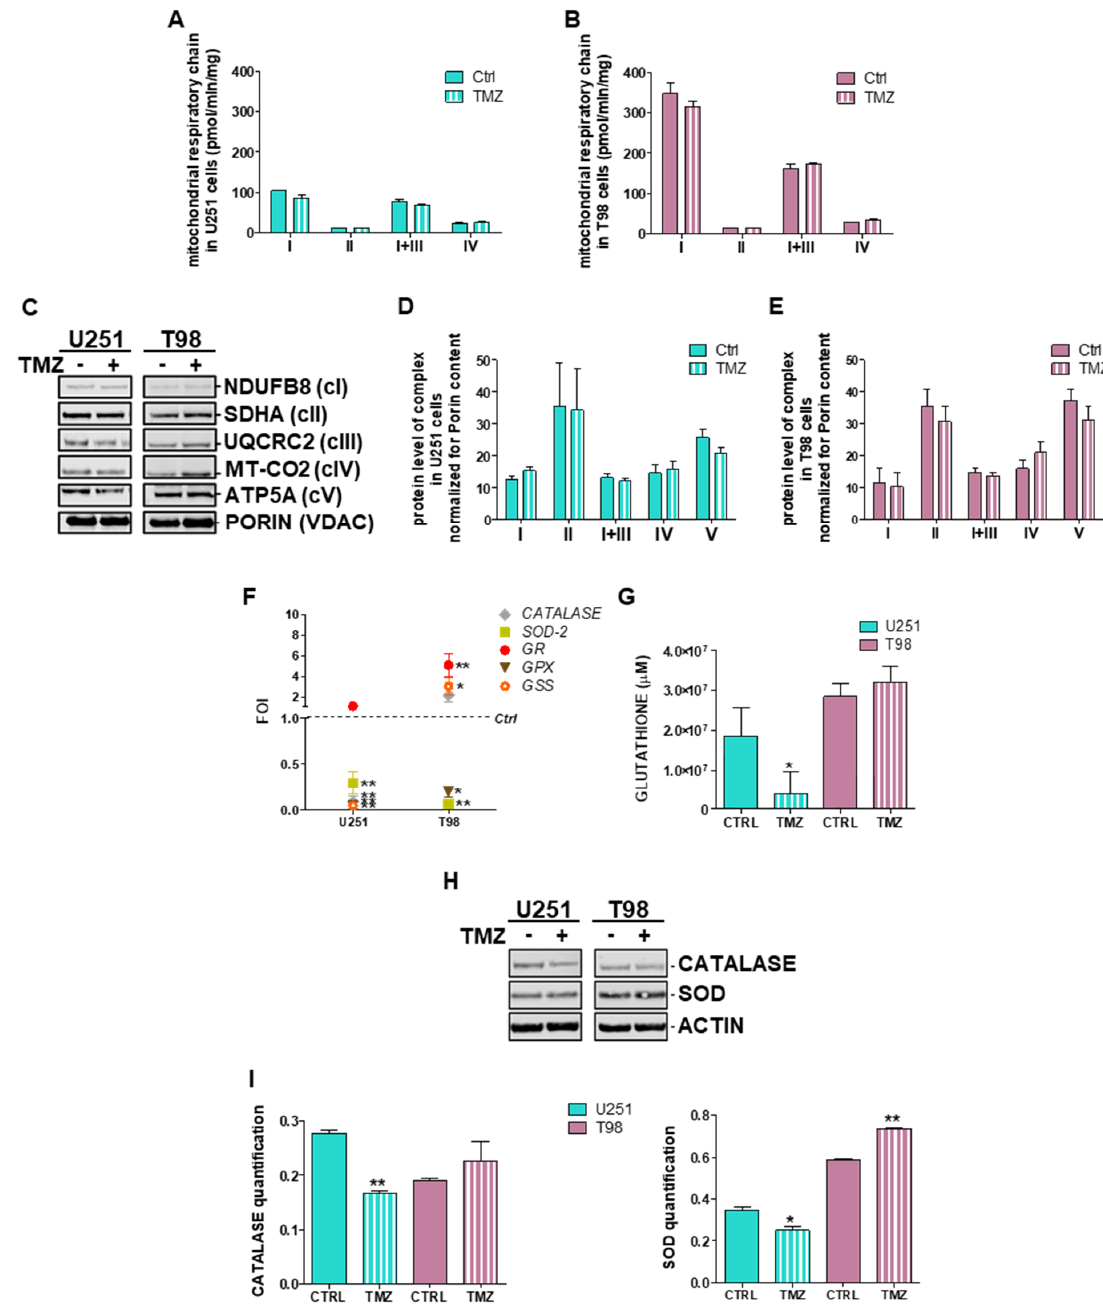
Figure 4. Deregulation of redox-homeostasis after Temozolomide treatment in U251 and T98 cells. ( A ) Spectrophotometric analysis of mitochondrial respiratory chain complex activities measured before and after 24 h of treatment with Temozolomide (TMZ) in U251 and ( B ) T98 cells. Values are expressed as mean values of complex I, II, I + III and IV normalized for citrate synthase activities (pmol / min / mg of proteins). ( C ) Descriptive image of Western Blot analysis of representative subunits of the mitochondrial respiratory chain assessed before and after 24 h of treatment with TMZ and their quantification in ( D ) U251 and ( E ) T98 cells. Values are expressed as mean values of protein content (arbitrary units) normalized for the signal of PORIN (VDAC). ( F ) Gene expression profile for detox enzymes ( SOD-2 , CATALASE , GLUTATHIONE PEROXIDASE - GPX- , GLUTATHIONE SYNTHETASE - GPS- , and REDUCTASE - GR- ) after treatment with 100 μM TMZ in U251 and T98 cells. Data were normalized for β-ACTIN , and the ΔΔCt values were expressed as FOI of the ratio